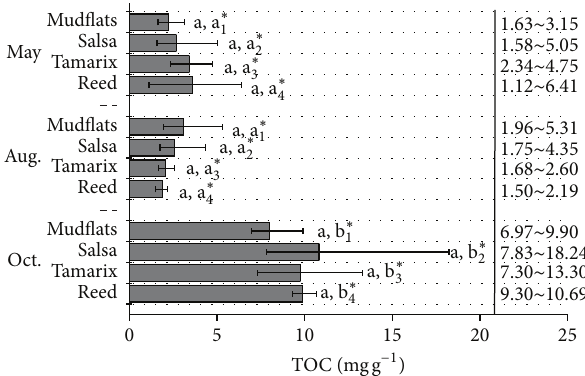
Figure 2: Soil TOC content in the four types of Yellow River estuary wetlands. The columns represent the average content of soil TOC, while the lines represent the variation range. The number at the right part is the range of TOC and the letters represent the difference of soil TOC in the different types of wetlands in the same season. The ∗ means the significant difference at the 0.05